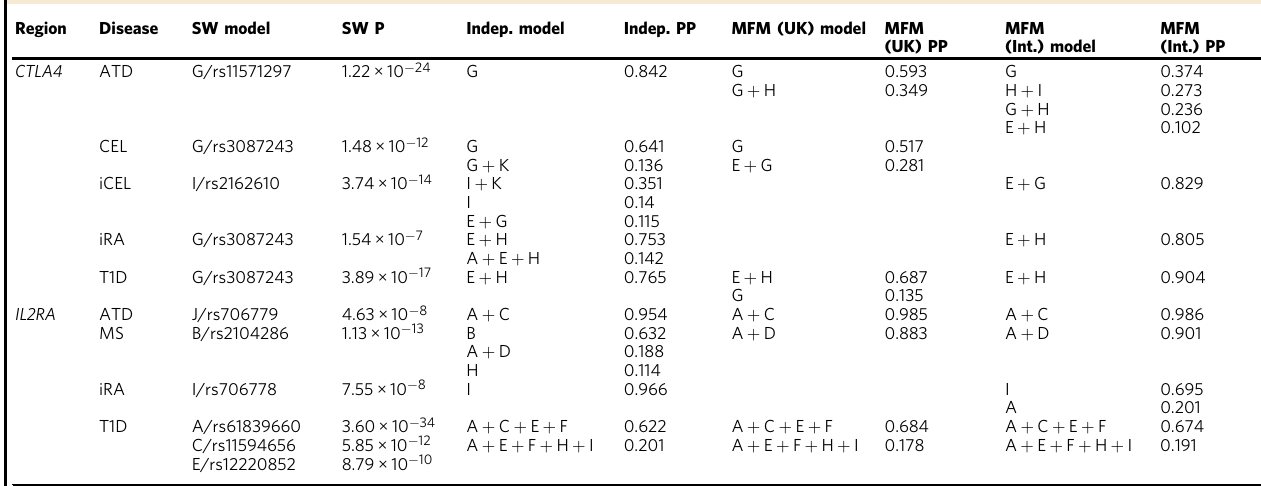
Table 3 Summary results for fi ne-mapping in CTLA4 and IL2RA Region